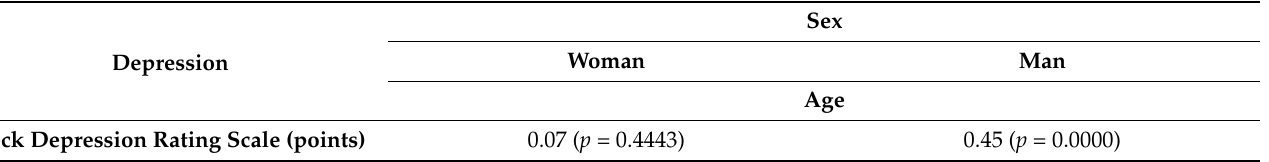
Table 10. Age and level of depression—Spearman’s rank correlation coefficients (along with an assessment of the statistical